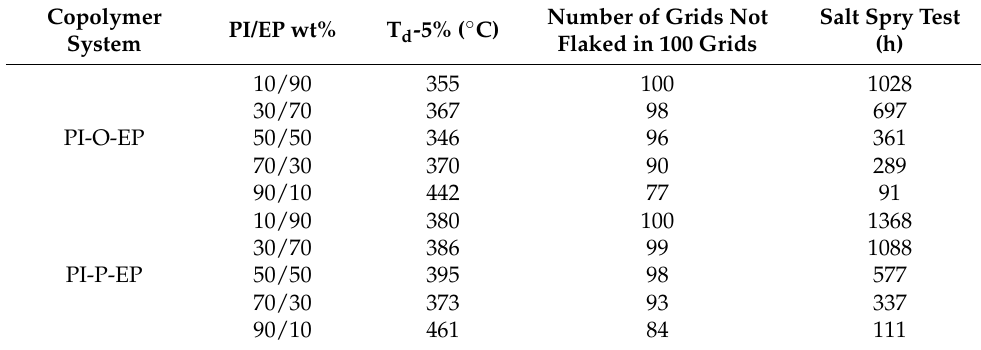
Table 3. T d (5%), cross cut adhesion test and salt spray